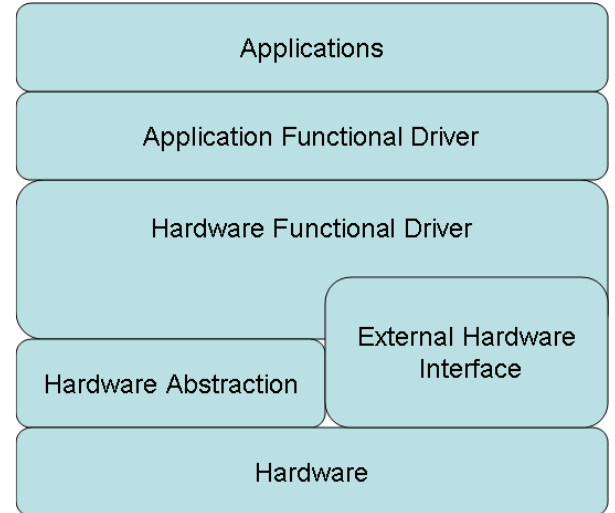
Figure 10. The architecture of the firmware on sensor